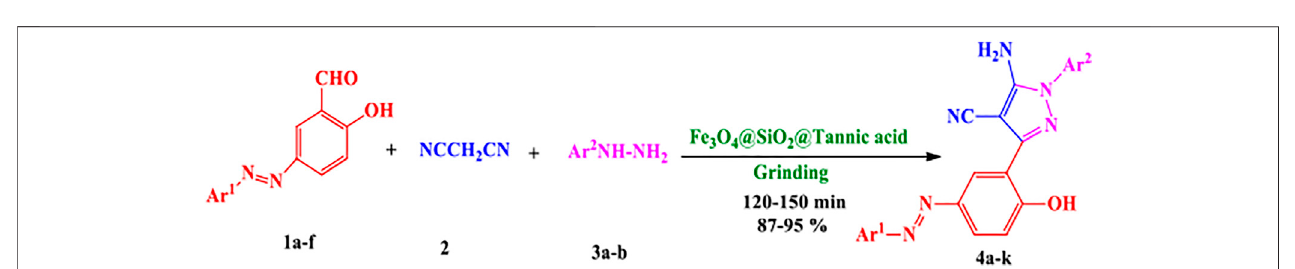
FIGURE 8 | XRD image of synthesized Fe 3 O 4 @SiO 2 @Tannic acid MNPs.